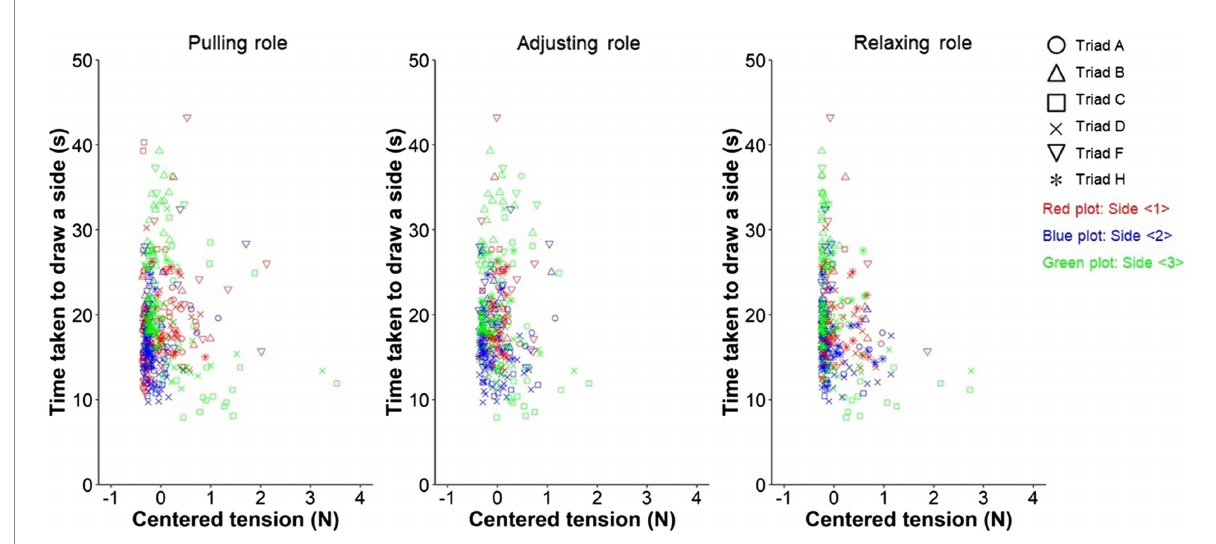
TABLE 4 Relationship between improved task performance through trials and tension peak values in the pulling and adjusting, and relaxing roles considering the variabilities between triads and sides.